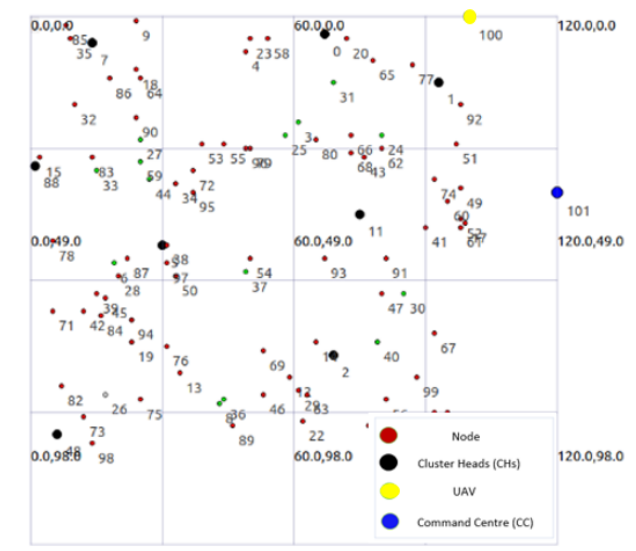
Figure 4. Topology of the network in NS-3. In Figure 4, the blue color is used for CC, the yellow color is used for UAV, the black color is used for CHs, the green color is used for GWs, the red is used for CMs, and the white color is used for Dead Nodes (DNs). The white nodes are not active and unable to communicate due to low or no E initial . This topology is obtained after running NS-3-based simulations for several rounds. The simulation parameters are shown in Table